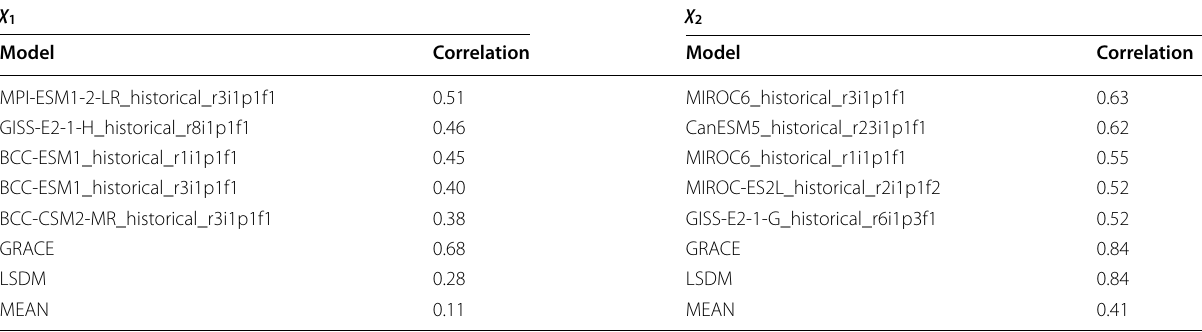
Table 7 Correlation coefficients between GAO and HAM from CMIP6 for χ coefficients are